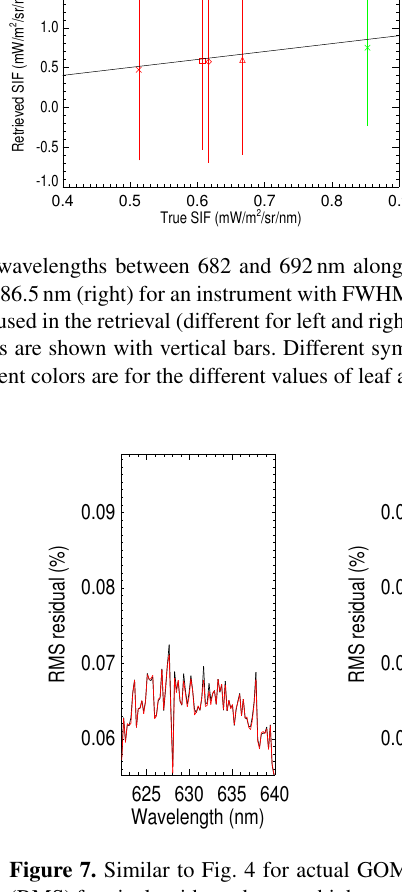
Figure 6. A sample GOME-2 observation made on 1 July 2012 at location specified in (a) ; observation and spectral fits of top-of- atmosphere (TOA) reflectance with and without SIF for the O 2 band retrieval in (b) and (c) . (c) is a spectral zoom of (b) , and residual of the reflectance spectral fit in (d) . The retrieved SIF at reference wavelength 682nm was 2.25mWm − 2 nm − 1 sr − 1 . RMS of the residual spectrum is 9.35 × 10 − 5 when SIF is fit and 1.01 × 10 − 4 when SIF is not fit.